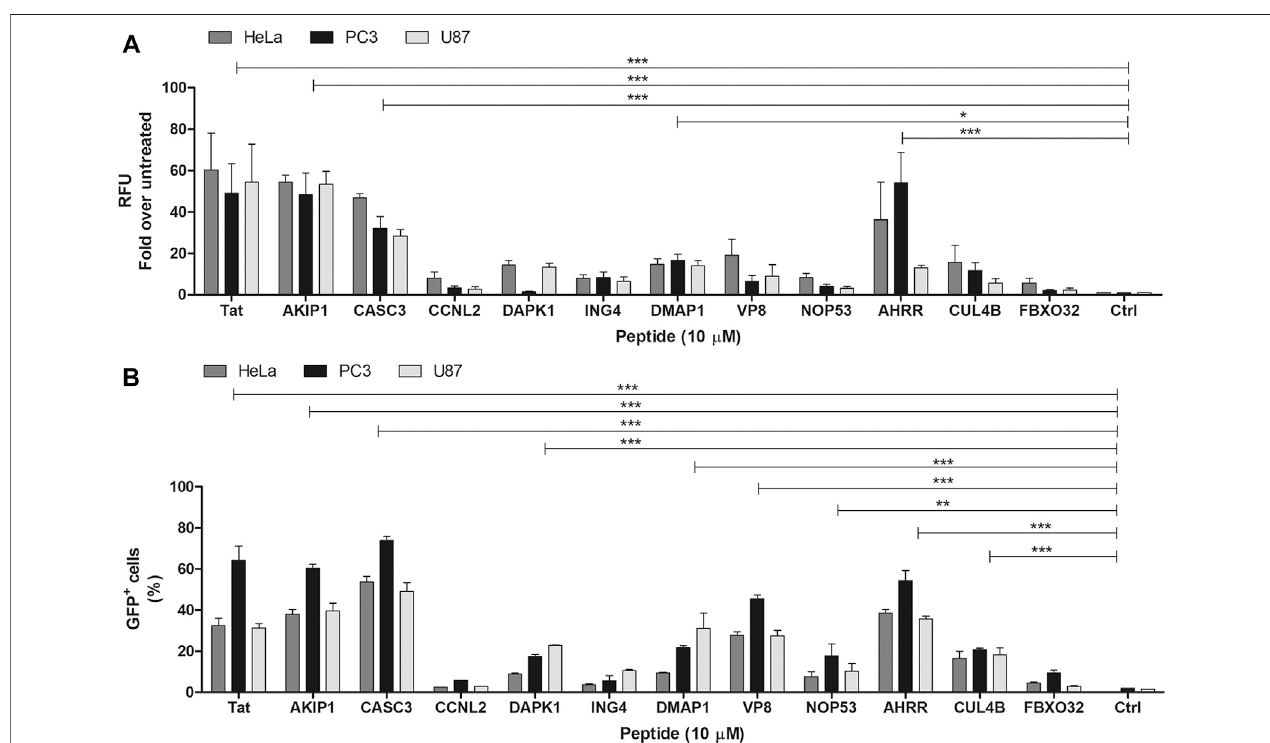
FIGURE 1 | (A) Internalization of the FAM-labelled peptides into the U87, PC3, and HeLa cells. The peptide ’ s concentration on the cells was 10 µM. The fl uorescence signal measured from the cell lysate 2 h after the addition of the peptide to the cells. The results are expressed as fold over untreated cells. The peptides names on the graph are shown as the protein names they are derived from (e.g., without location in the protein sequence). (B) Percentage of the labelled cells after the addition ofthe fl uorescently labelled peptides. Measured from the U87, PC3, and HeLa cells. The peptide ’ s concentration on the cells was 10 µM. The fl uorescent signal detected 2 h after the addition of the peptides to the cells. The untreated cells were used to set the threshold for the fl uorescent signal. Two-way ANOVA with Bonferronipost-testwasusedforthestatisticalanalysisofthetreatmentgroupstountreatedcontrol.ns(notmarked)indicates p > 0.05;*indicates p < 0.05;**indicates p < 0.01; *** indicates p <